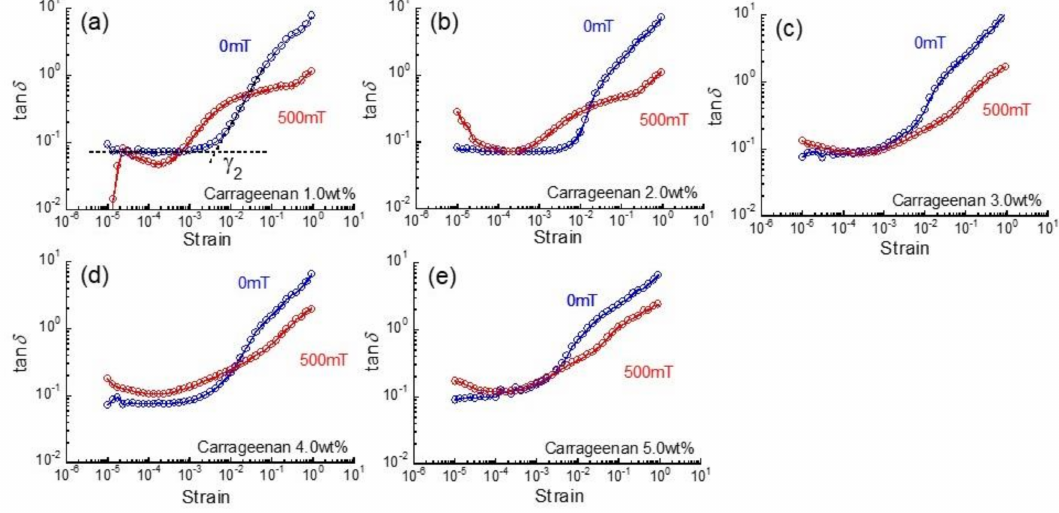
Figure 4. Strain dependence of loss tangent at 0 and 500 mT for magnetic hydrogels with various carrageenan concentrations (CI: 70 wt%, f = 1 Hz), ( a ) 1.0 wt%, ( b ) 2.0 wt%, ( c ) 3.0 wt%, ( d ) 4.0 wt%, ( e ) 5.0